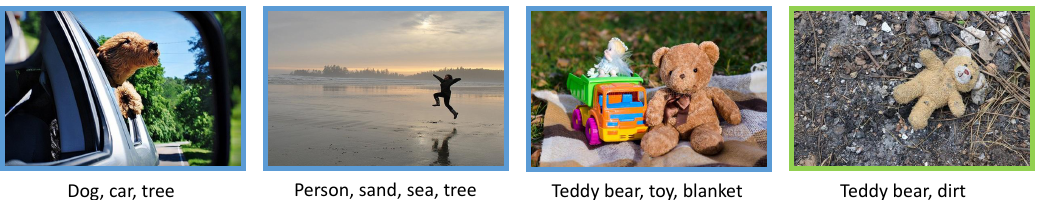
Figure 1. Examples of image sentiment. The blue border represents positive sentiment, while the green border represents negative. We show the categories of objects obtained by panoramic segmentation under the